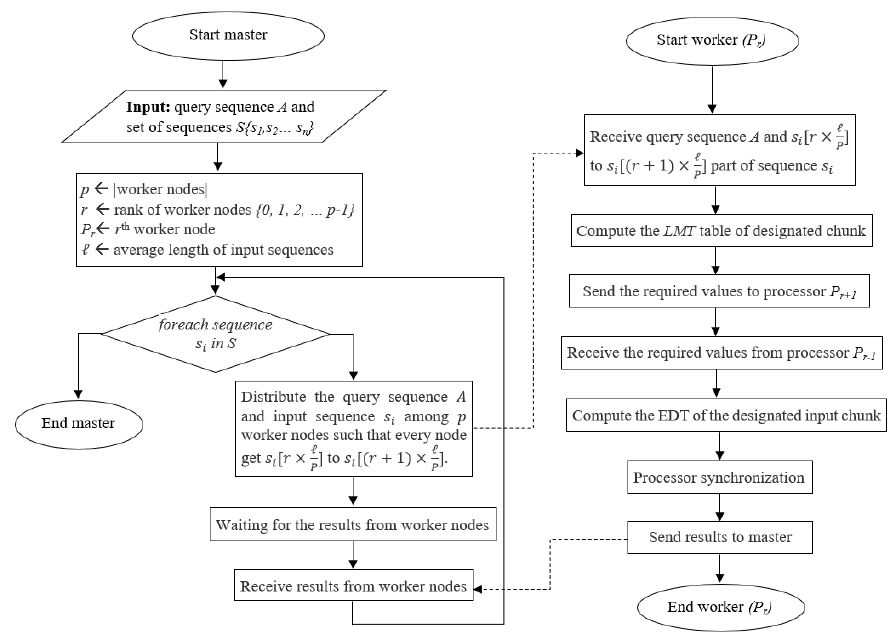
Figure 7. Flowchart of intra-task parallelism approach. The dotted lines show the communication between master and worker